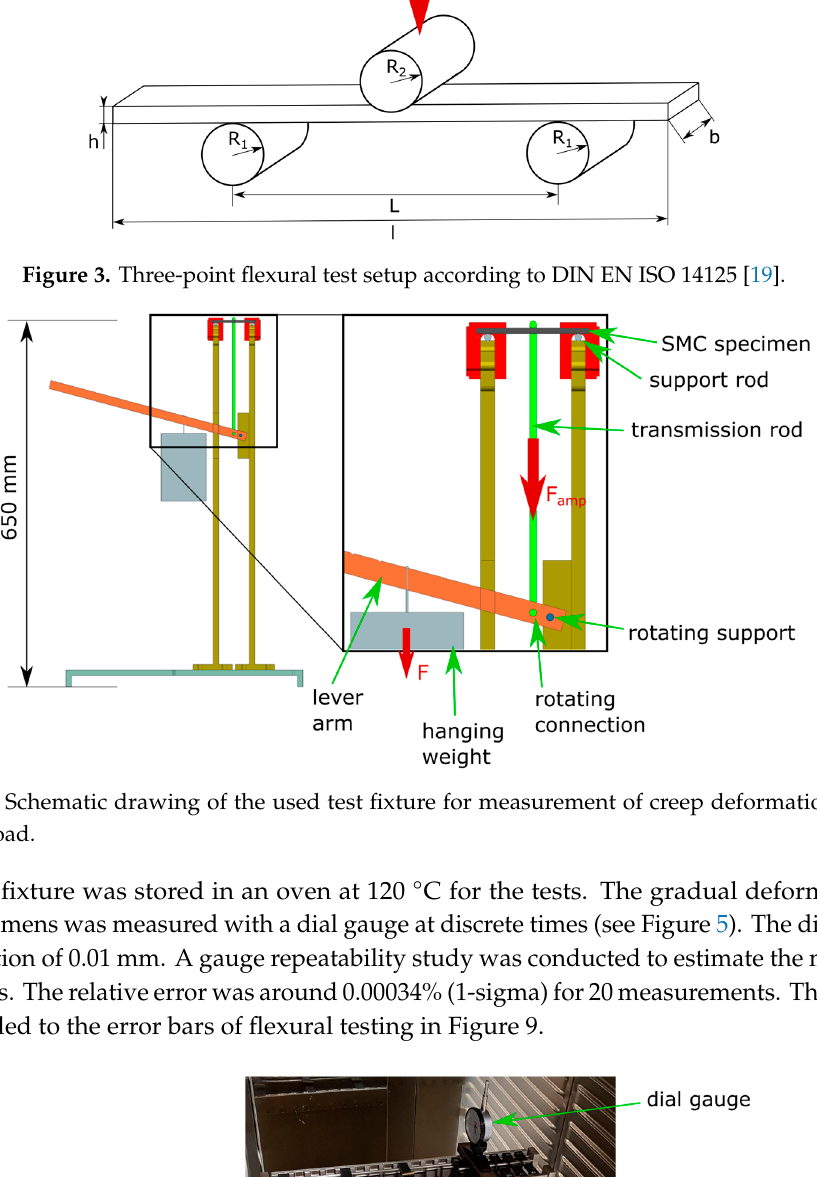
( b ) Figure 2. Dynamic mechanical analysis (DMA) in a DMA 850 (TA Instruments Inc., New Castle, PA, USA) of SMC material Polynt SMCarbon 80 CF60-3K/2: ( a ) Dual-cantilever measuring setup for determining the glass transition; ( b ) storage-modulus- and tan( δ )-graph from − 20 to 220 °C. Static mechanical flexural testing was conducted at an ambient temperature and 120 °C with 10 specimens per test. Test results are summarized in Table 1. Table 1. Measured mechanical material properties of investigated carbon fiber SMC [18]. Material Property